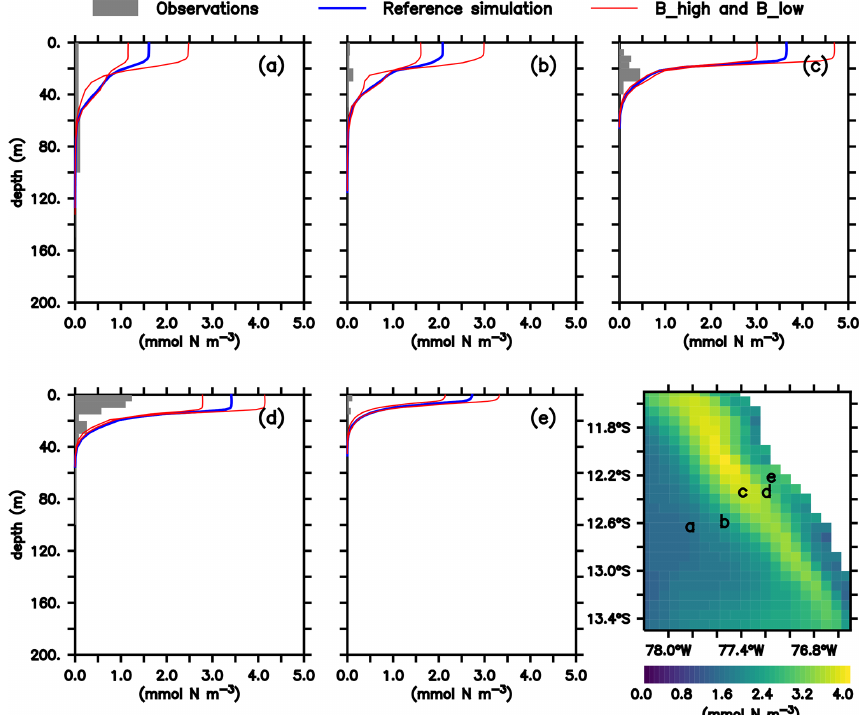
Figure 2. (a–e) Zooplankton concentrations (mmolNm − 3 ). Lines indicate modelled large zooplankton concentrations in the reference sce- nario and experiments B_high and B_low averaged from January to March. Shaded area shows observed nighttime mesozooplankton biomass concentrations over the sampled depth intervals (m). Observations are lower than 0.1mmolNm − 3 below 200m; thus they have not been in- cluded. For a plot including deep-water observations, please see Appendix B, Fig. B1, and Fig. 4 in Kiko and Hauss (2019). Bottom right: modelled large zooplankton biomass concentration at the surface in the reference scenario (mmolNm − 3 ) and locations where observations were collected.